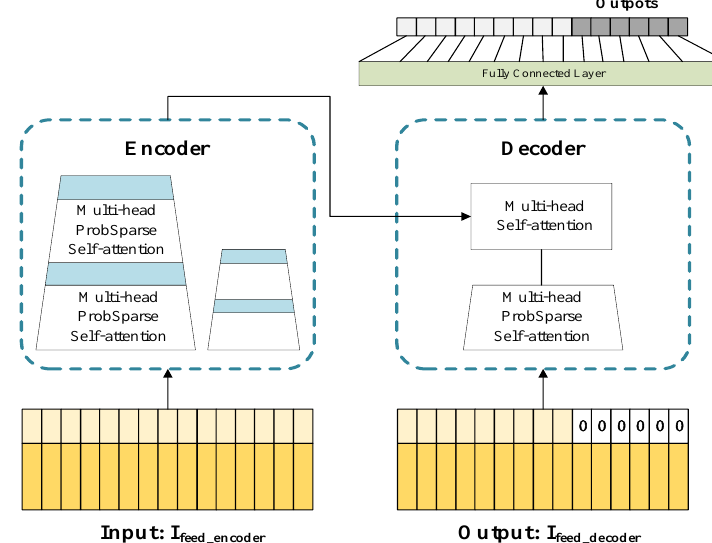
Figure 2. Informer structure diagram.